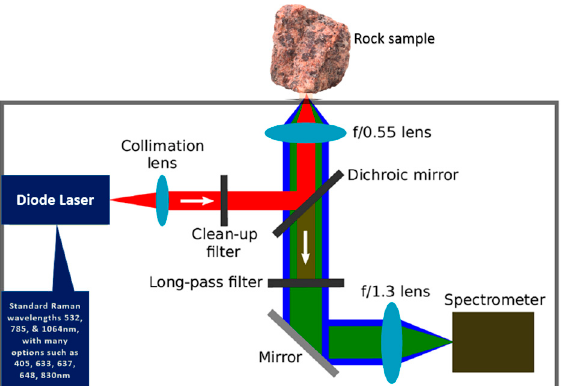
Minerals 2022 , 12 , x FOR PEER REVIEW Figure 12. Schematic diagram of a typical handheld Raman spectrometer system, modified from [113].